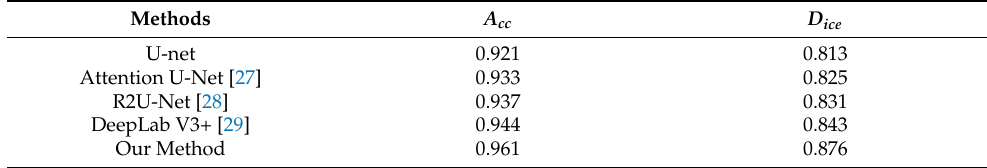
Table 1. Performance comparison of image segmentation of different deep learning